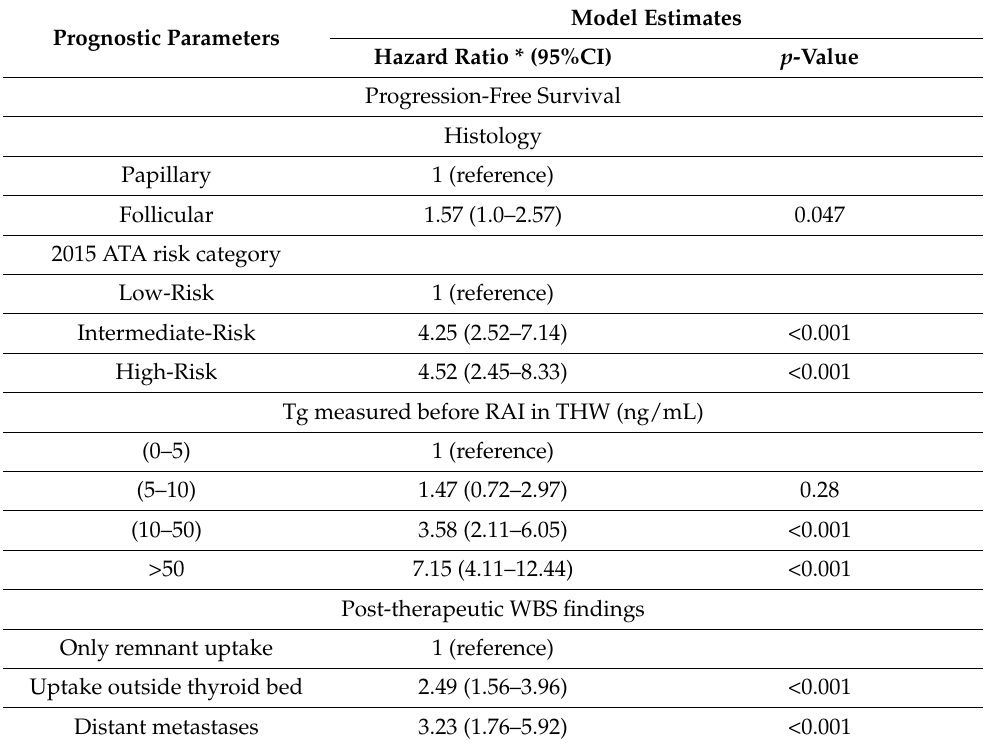
Table 3. The Cox model was calculated to confirm the significant effect of each prognostic parameter on the